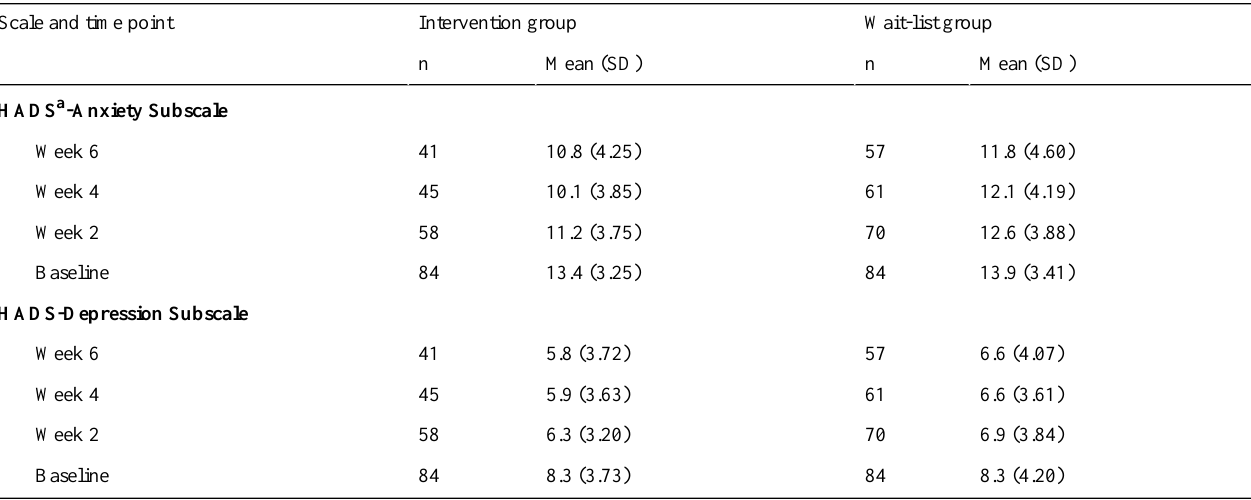
Table 2. Hospital Anxiety and Depression Scale anxiety and depression scores by study arm at baseline and at 2, 4, and 6 weeks of follow-up.